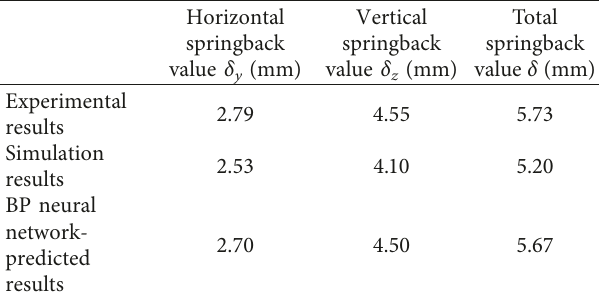
Table 6: Comparison of experimental results, simulation results, and BP neural network-predicted